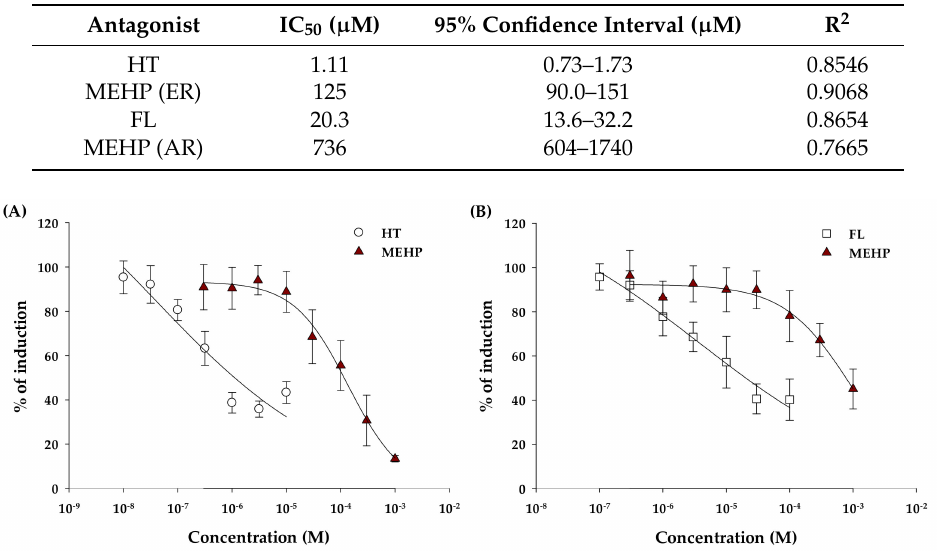
Figure 3. Sigmoidal dose-response curves for antagonistic potential of MEHP to estrogen ( A ) and androgen ( B ) receptor activity,